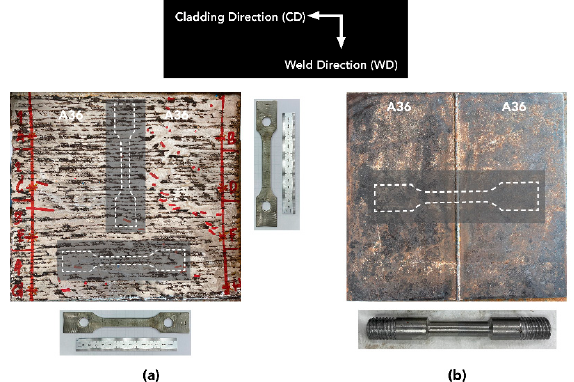
Figure 4. The residual stress measurement: ( a ) Residual stress measurement before cladding; ( b ) Residual stress measurement after cladding.